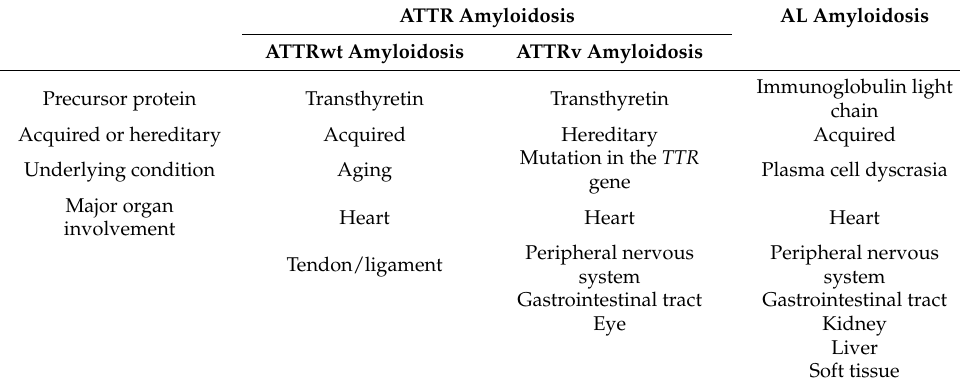
Table 1. Characteristics of ATTR and AL